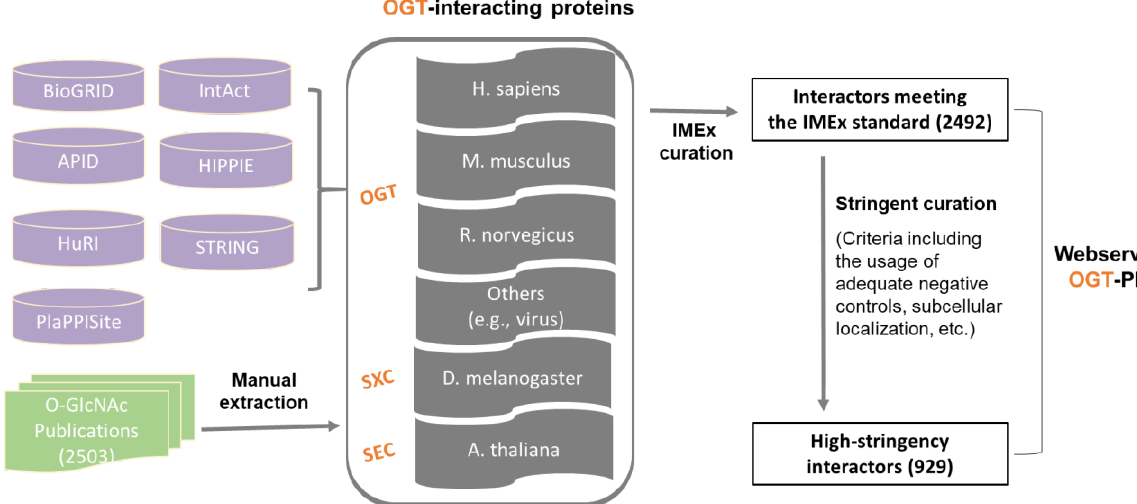
Figure 1. Assembly of the experimentally identified OGT-interacting protein database. In total, information of OGT interactors was extracted from seven public repositories (i.e., BioGRID, APID, IntAct, HuRI, HIPPIE, STRING, and PlaPPISite) and 2503 O-GlcNAc-focused publications. OGT interactors were first curated by following the single joint International Molecular Exchange (IMEx) consortium curation manual and then curated with more stringent criteria (as described in detail in ‘Methods’). Information of both interactors meeting the IMEx standard and interactors with high-stringency was included in the webserver